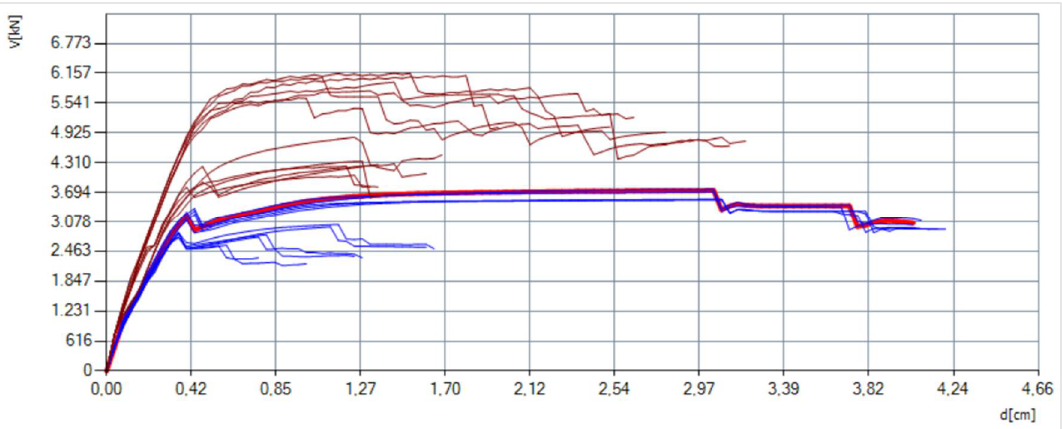
Figure 14. Capacity curves for x (blue) and y (red) direction. The bright red color represents a critical result.